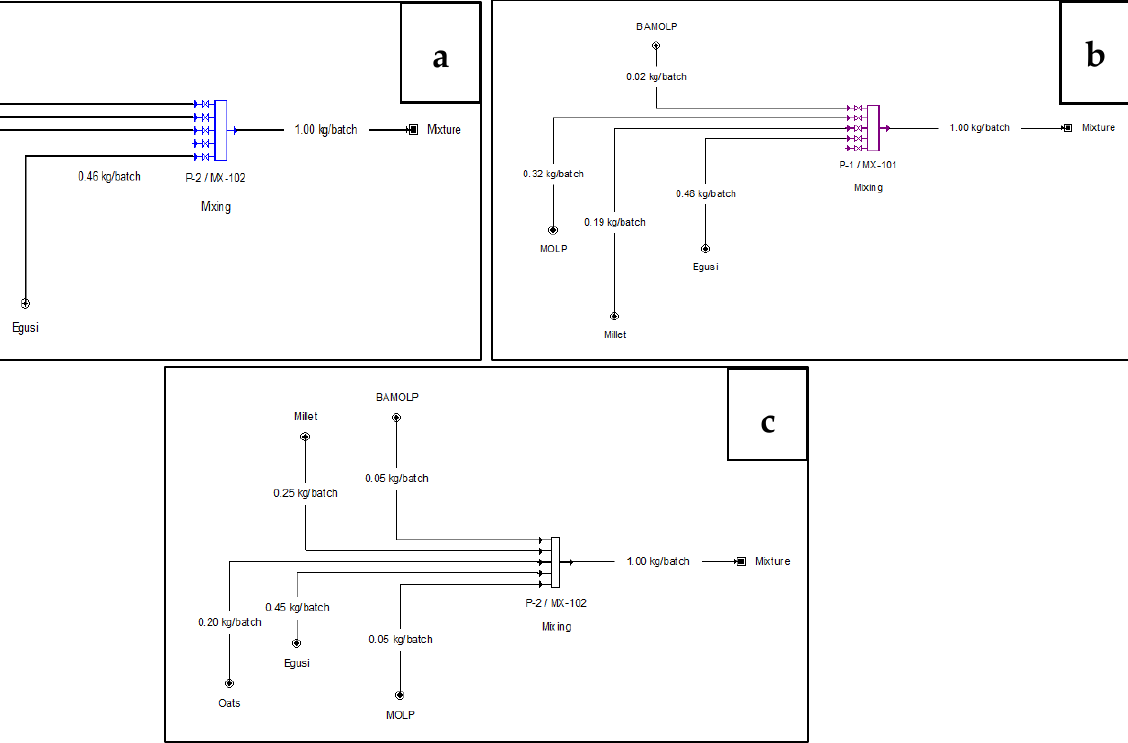
Figure 1. Process flow diagram of Bambara groundnut– Moringa oleifera snack bar enriched with Bambara groundnut-Moringa oleifera leaf protein (BAMOLP) at low, medium, and high concentrations, ( a ) oats plus 3% BAMOLP, ( b ) millet plus 2% BAMOLP, ( c ) oats, millet, and 5% Table 1. Proximate composition of ingredients.